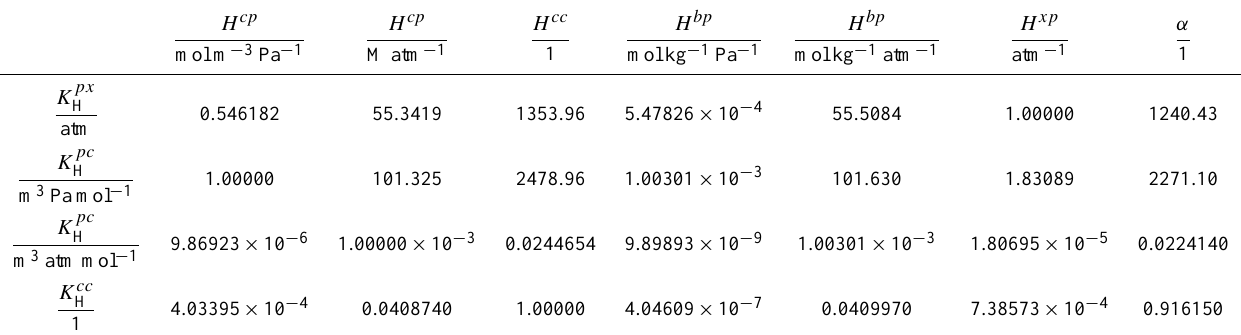
Table 3. Products of Henry’s law solubility constants H and Henry’s law volatility constants K H (at T (cid:9) = 298.15K and % (cid:9) = 997kg m − 3 ). = 5atm, then H bp ≈ 11mol ( kgatm ) − 1 because 5 × 11 ≈ 55 . For example, if K px H